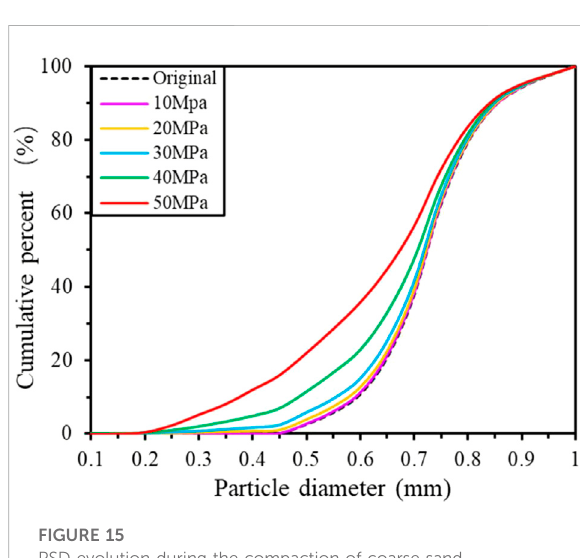
FIGURE 14 Evolution of the particle number and breakage times during the compaction of coarse sand.